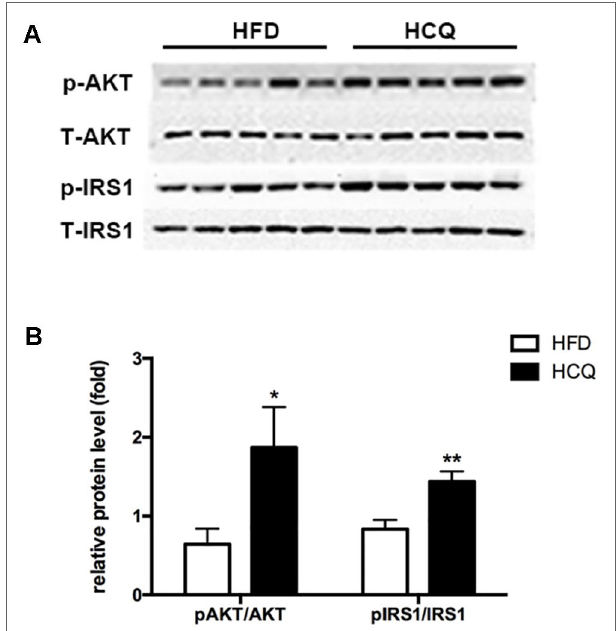
FIGURE 5 | Effects of HCQ on the HFD-induced insulin signal pathway. The phosphorylation of IRS-1 (Tyr896) and Akt (Ser473) were markedly increased by HCQ in HFD-induced mice. (A) (f) Representative western blots, (B) Grayscale statistical map. Data were presented as mean ± standard error of the mean (SEM) in the HFD and HCQ groups. Significant difference: * P < 0.05 and ** P < 0.01 vs. the HFD